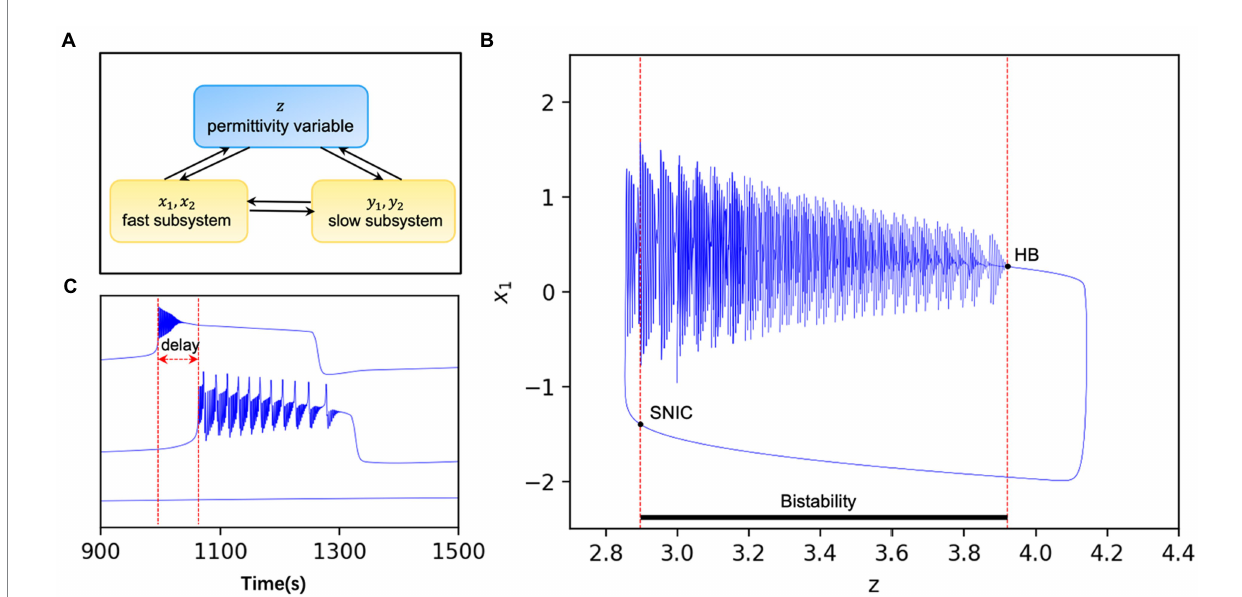
FIGURE 1 (A) Pattern diagram of the model. , 1 2 x x are the fast subsystems and , 1 2 y y are the slow subsystems. In addition to their direct interaction, the two subsystems can also interact with each other indirectly through the extracellular environmental, i.e., the permittivity variable z . (B) The system is bistable when the permittivity variable z lies between two bifurcation points and loses stability when the stable limit ring passes through the HB or the stable point passes through SNIC. The whole system varies periodically with time modified from Guo et al. (28). (C) Discharges of nodes with different excitability in the same network. When 0 x x threshold > , the model is in the seizure state and the oscillator will switch periodically between the seizure and interseizure periods (upper panel). When 0 x when 0 x x threshold <